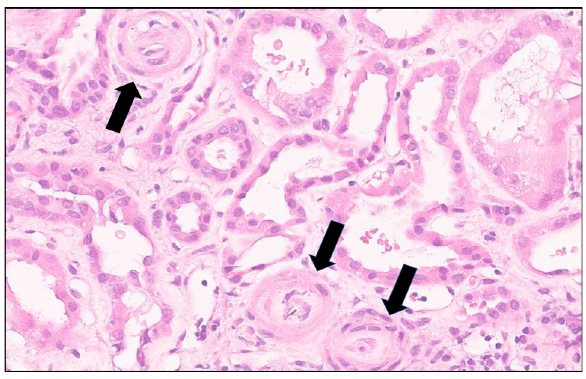
Figure 2. Black arrows point to endarteritis obliterans.